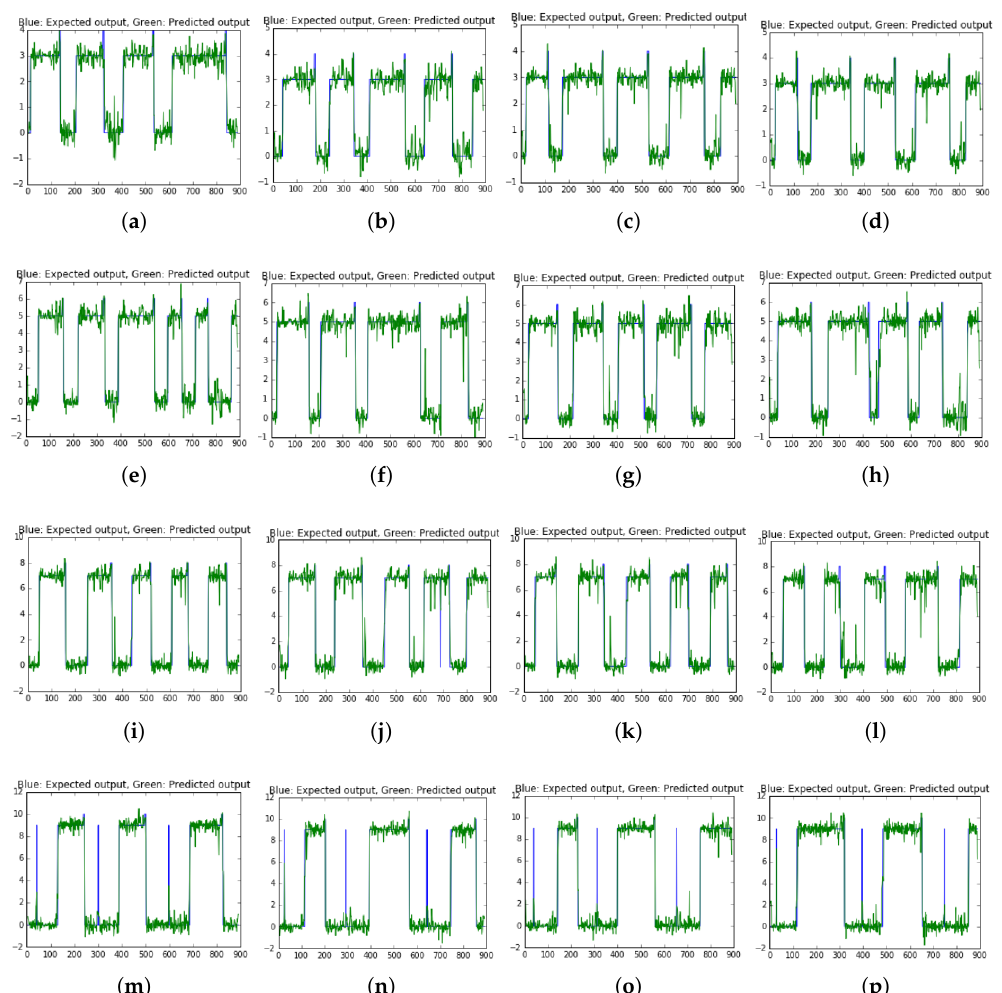
Figure A4. Classification results of LSTM model on test 5 to test 20 data: ON/OFF label is expected output with Blue color; ON/OFF label is predicted output with Green